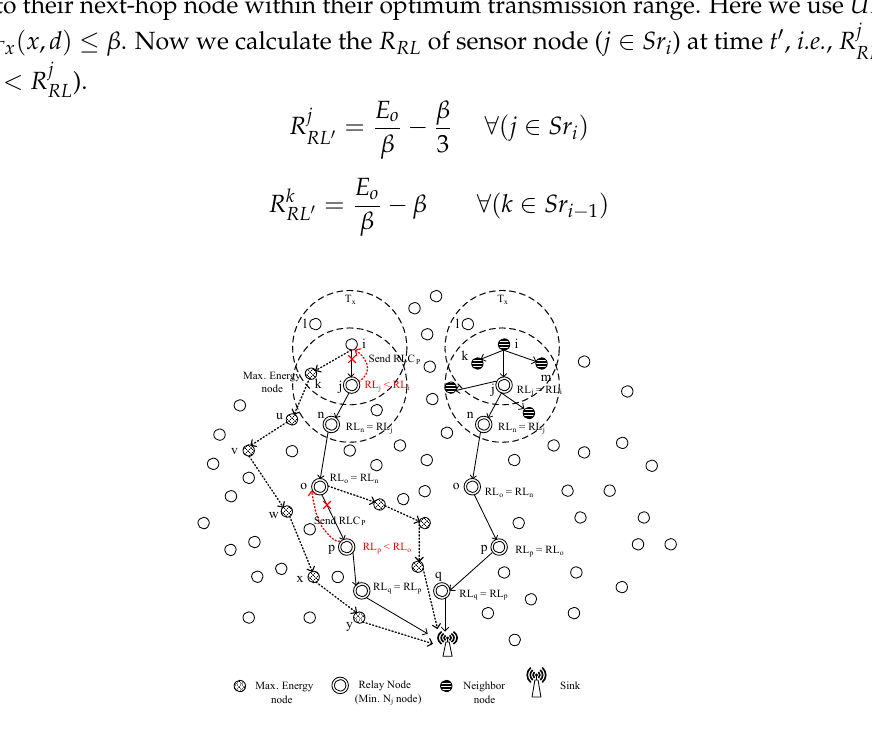
Figure 6. Variations in relay node selection based on energy